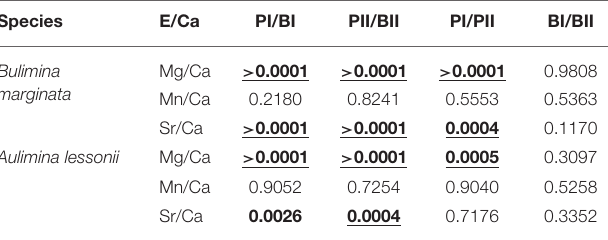
TABLE 6 | Two-tailed p- values of unpaired t -test of comparison of means of primary and secondary peak (PI and PII) and base (BI and BII) values of E/Ca acquired by